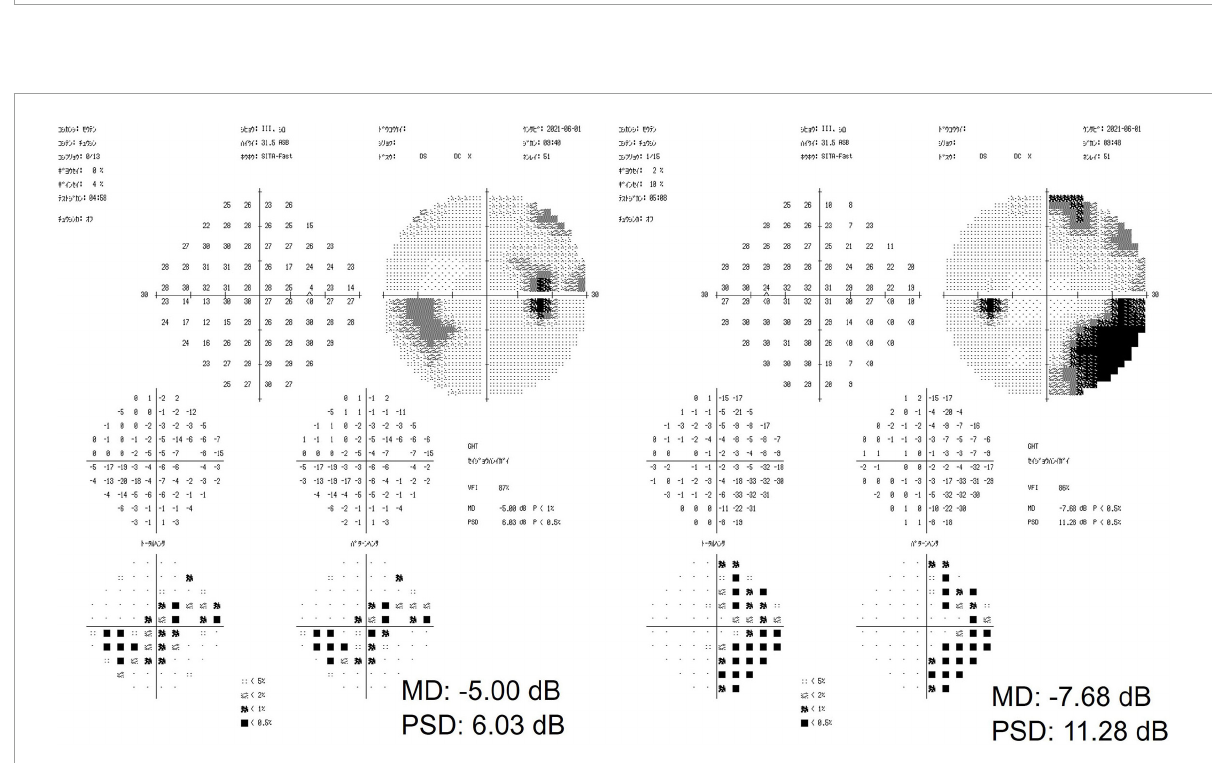
FIGURE2 The results of a visual field examination using a Humphrey field analyzer. In the right eye, a visual field defect in the nasal inferior aspect corresponded to a defect in the retinal nerve fiber layer. In both eyes, a right-sided homonymous hemianopia-like visual field defect was